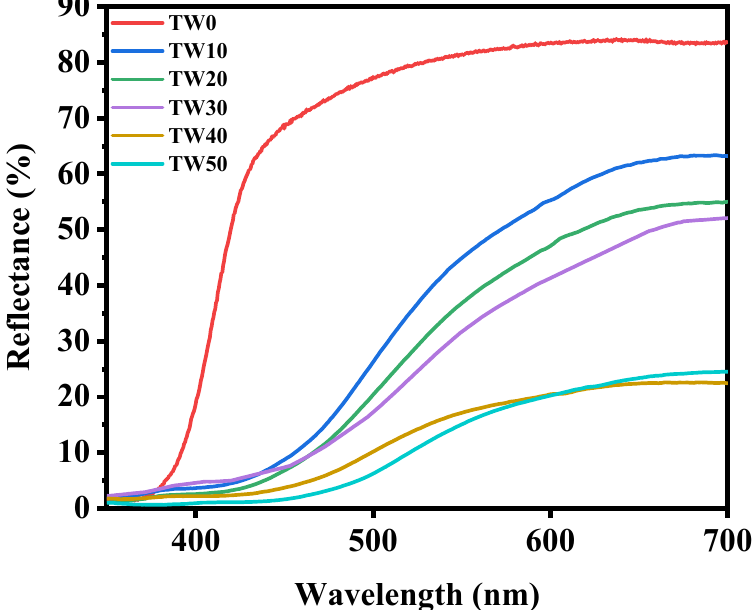
Figure 4. UV-Vis diffuse reflectance spectra of TW0, TW10, TW20, TW30, TW40 and TW50 nano- fibers.